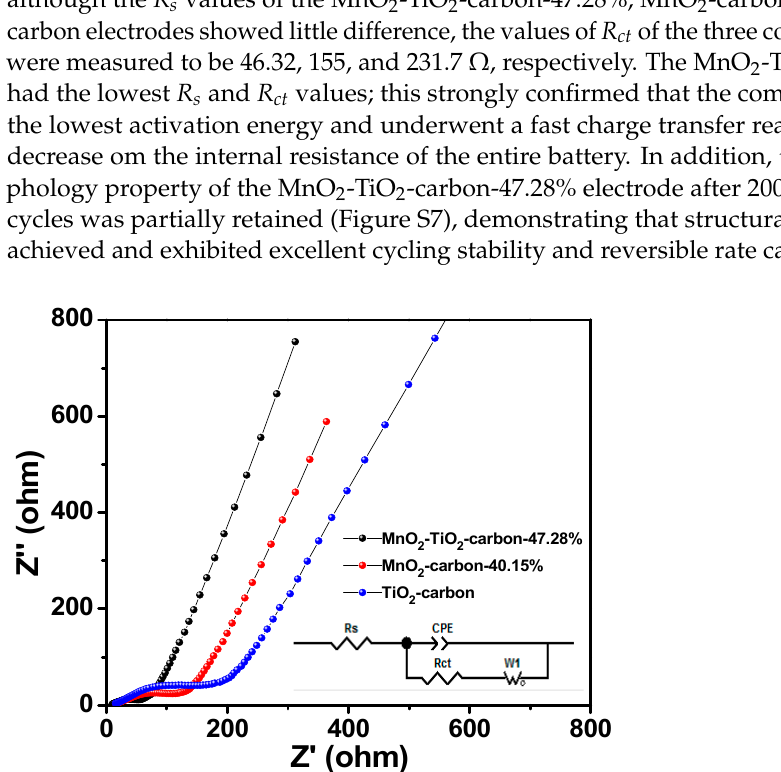
Figure 10. Electrochemical impedance spectra (Nyquist plots) of the MnO 2 -TiO 2 -carbon-47.28%, MnO 2 -carbon-40.15% and TiO 2 -carbon electrodes after 200 charge/discharge cycles. The inset is the equivalent circuit model used to fit the impedance spectra.